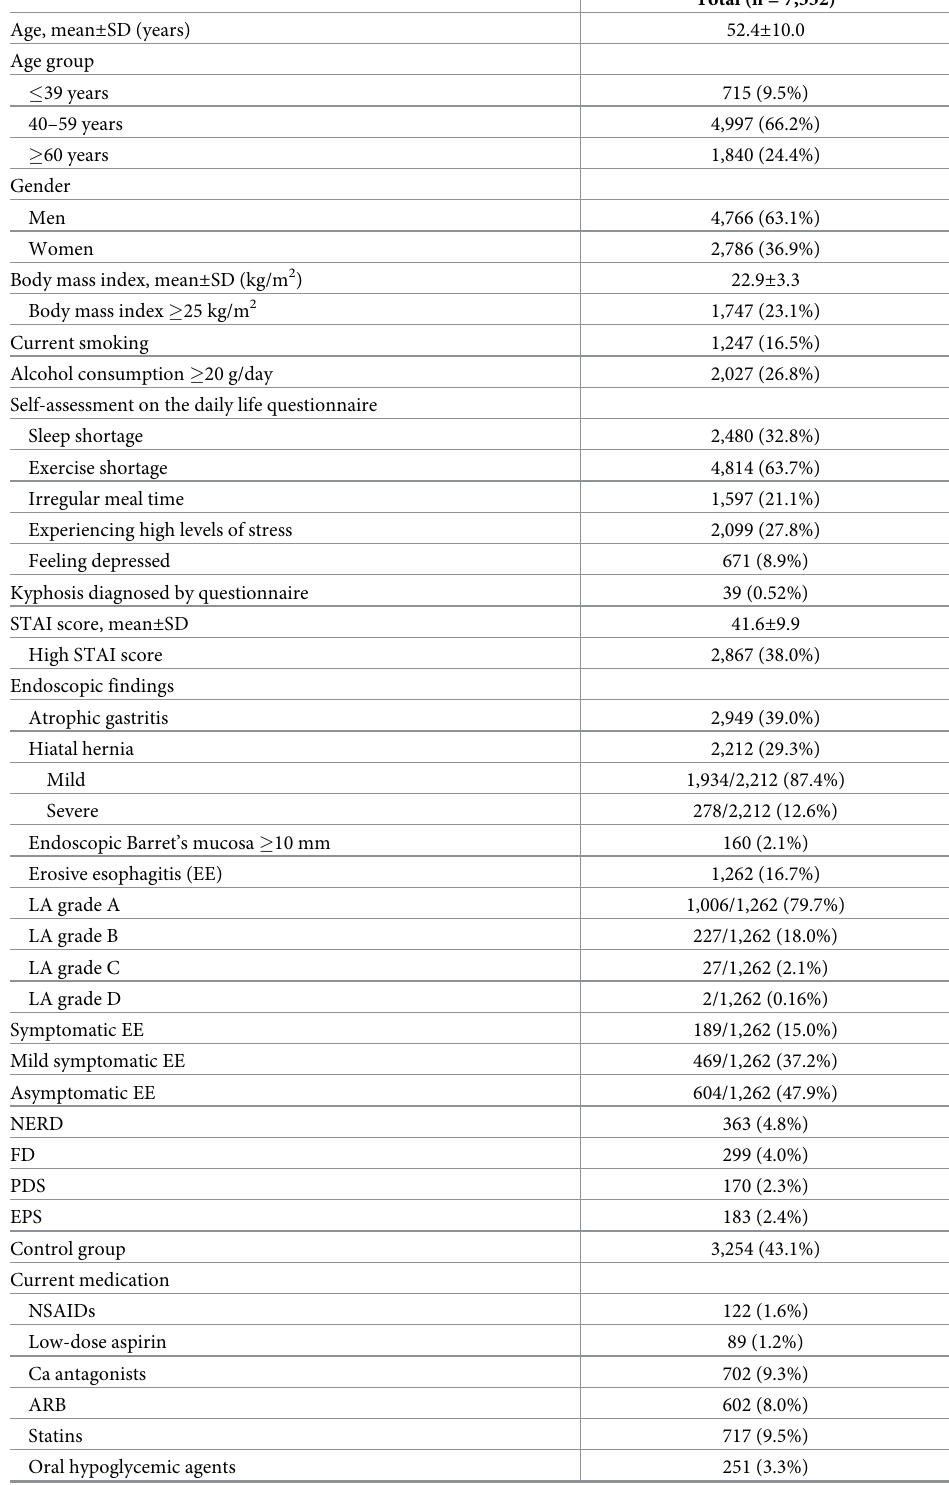
Table 1. Characteristics of the study